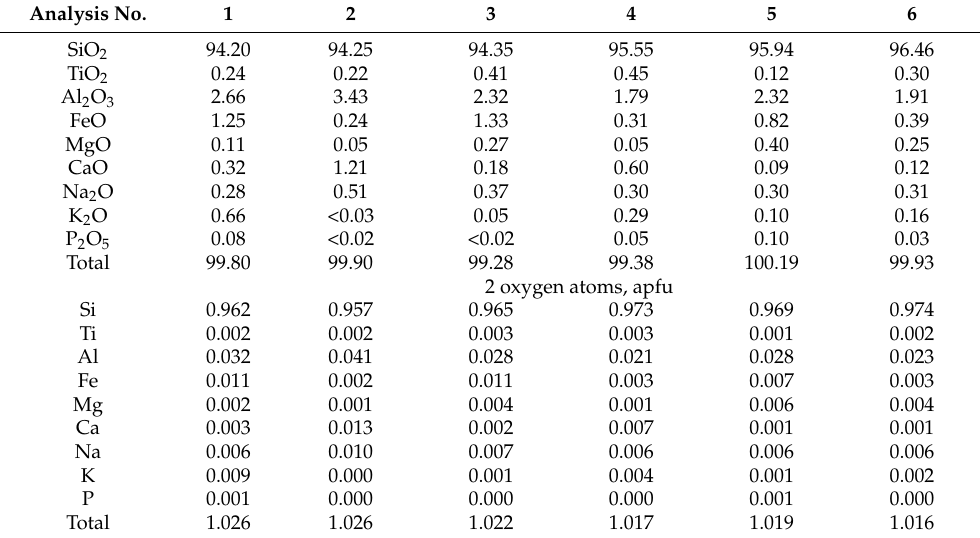
apfu = atoms per formula unit; MnO < 0.06